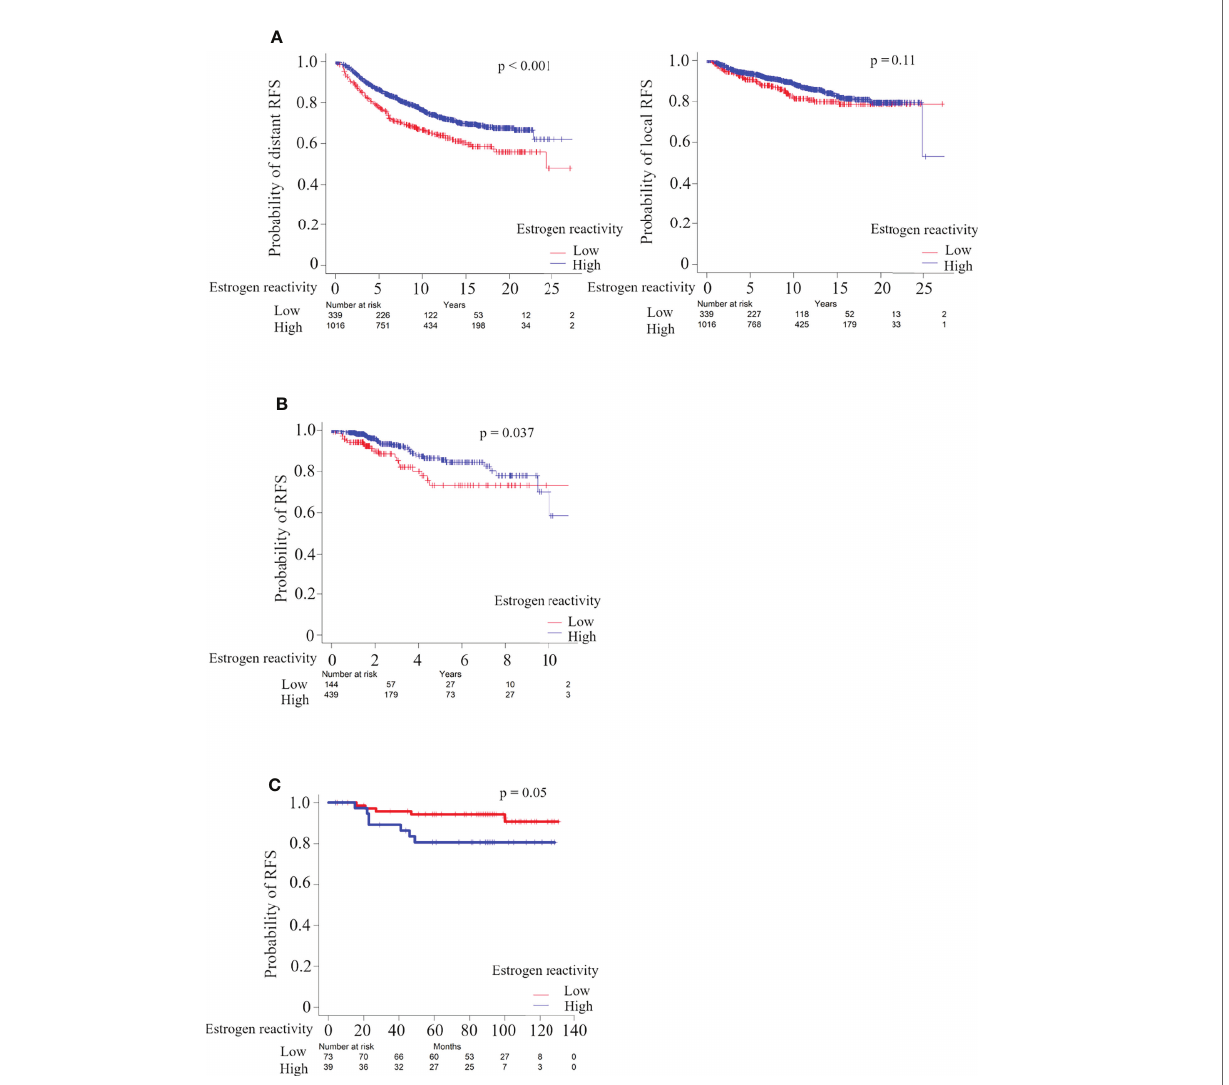
FIGURE 5 | Analysis of the relationship between estrogen reactivity and survival in METABRIC and TCGA and our cohort. Kaplan-Meier plots of the association of estrogen reactivity with distant RFS in METABRIC (A) and RFS in TCGA (B) and in our cohort (C) . RES, recurrence-free survival; METABRIC, Molecular Taxonomy of Breast Cancer International Consortium; TCGA, The Cancer Genome Atlas; RFS, recurrent-free